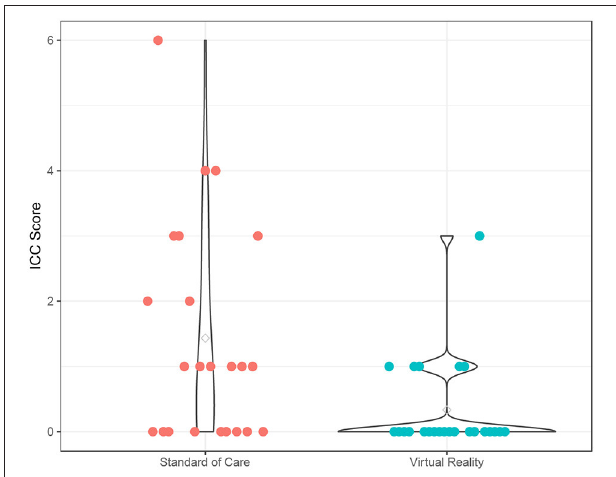
FIGURE 4 | Procedural Compliance. Procedural Compliance of Virtual Reality (VR) and SOC groups as measured by the modified Induction Compliance Checklist (mICC). Higher scores on the ICC indicate less procedural